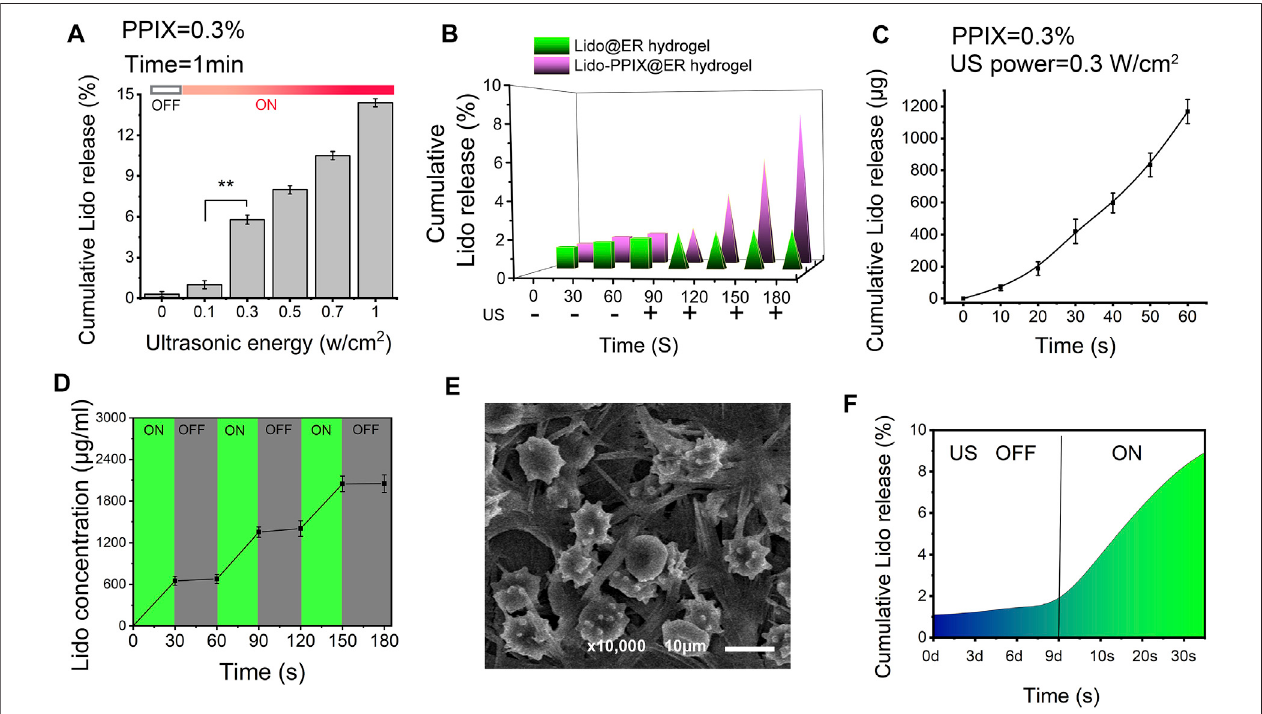
FIGURE 4 | Ultrasound-triggered release behavior of the Lido-PPIX@ER hydrogel. (A) In vitro lidocaine release from the Lido-PPIX@ER hydrogel at increasing ultrasoundpowerat37 ° C. (B) Invitro lidocainereleasefromtheLido@ERhydrogelorLido-PPIX@ERhydrogelwithorwithoutlaserintensitiesat37 ° C(0.3 W/cm 2 ,60 s). (C) Releasepro fi leoflidocainefrom1.0 mlofLido-PPIX@ERhydrogelduringcontinuousultrasoundtriggering. (D) Invitro releasepro fi leoflidocainewhentheultrasound was cyclically varied between on and off for several repetitions. (E) Morphological changes of Lido-PPIX@ER during “ on-off ” lidocaine release. (F) Ultrasound- triggered release behavior of the Lido-PPIX@ER hydrogel after storage in PBS at 4 ° C for 9 days.